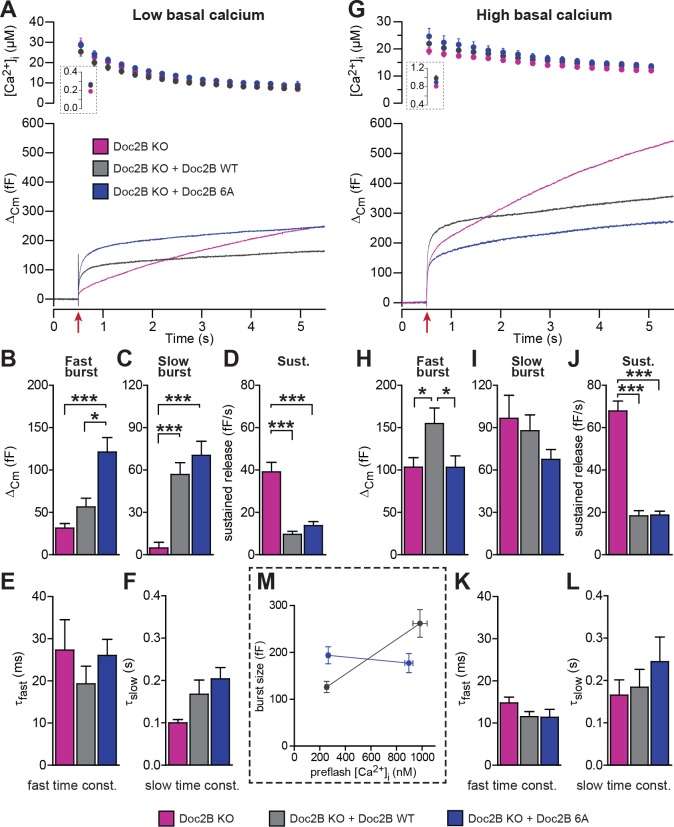
Mutation of the Ca2+binding sites of Doc2B leads to permanent membrane localization and Ca2+-independent priming.(A-F) When stimulated from low basal calcium, the Ca2+-binding mutant Doc2B 6A supports more secretion that Doc2B WT. (A) Ca2+ uncaging in Doc2b KO cells (n = 23), KO cells overexpressing Doc2B WT (n = 19) and KO cells overexpressing Doc2B 6A (n = 18). Panels are arranged as in Figure 4. (B–F) Kinetic analysis revealed that the fast burst was increased more by overexpression of Doc2B 6A than by Doc2B WT, showing a gain of function of the 6A mutant at low basal cell calcium. The sustained component was similarly decreased by overexpression of either protein. *p<0.05, ***p<0.001; Dunn’s multiple comparison test. (G) similar experiment to (A) but stimulated from high basal pre-flash [Ca2+]i (Doc2B KO, n = 25 cells; Doc2B WT, n = 21 cells; Doc2B 6A, n = 22 cells). (H–L) Kinetic analysis shows that overexpression of Doc2B WT caused a marked increase in the fast burst while Doc2B 6A did not, demonstrating a loss of function when studied from a high basal [Ca2+]. Similar to the low [Ca2+]i experiment, the sustained component was decreased to the same levels by overexpression of both proteins. *p<0.05, Tukey’s multiple comparison test; ***p<0.001, Dunn’s multiple comparison test. (M) Plot of the total burst size (fast + slow) as a function of the basal cell calcium reveals the Ca2+-independent priming reaction in the presence of the 6A mutant.